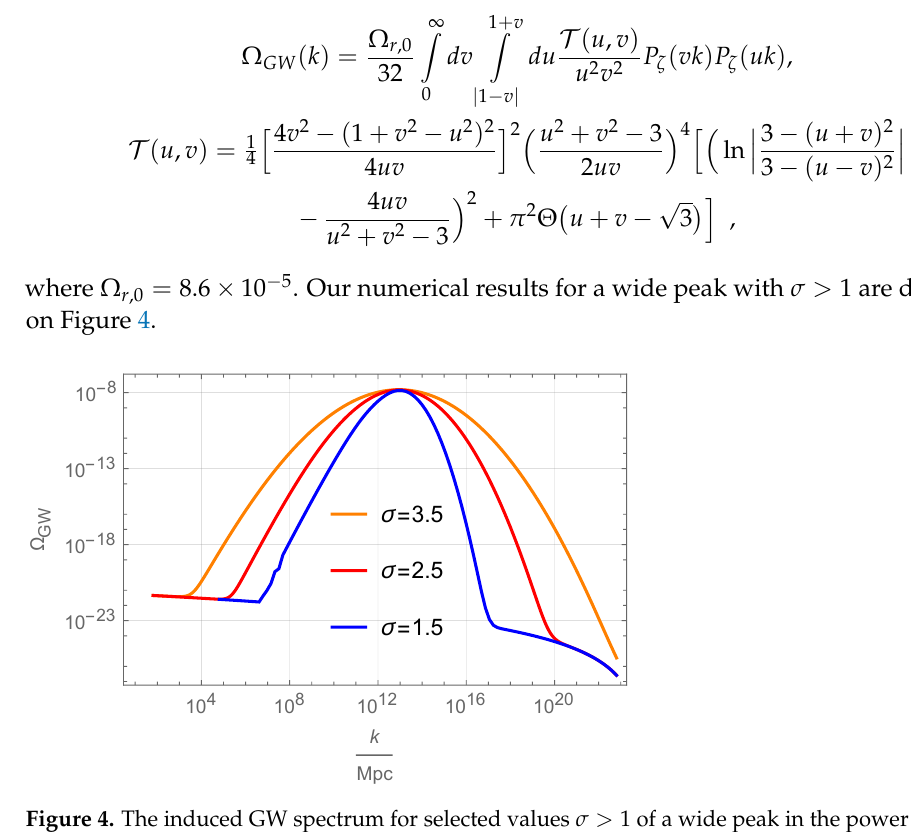
Figure 4. The induced GW spectrum for selected values σ > 1 of a wide peak in the power spectrum, with the parameters P 0 = 6.57 × 10 − 13 , k peak = 10 13 Mpc − 1 and k final = 7.7 × 10 23 Mpc − 1